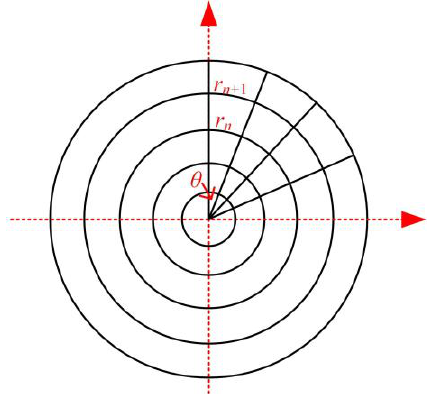
Figure 2. Mesh grids of the gain medium and saturated absorber.